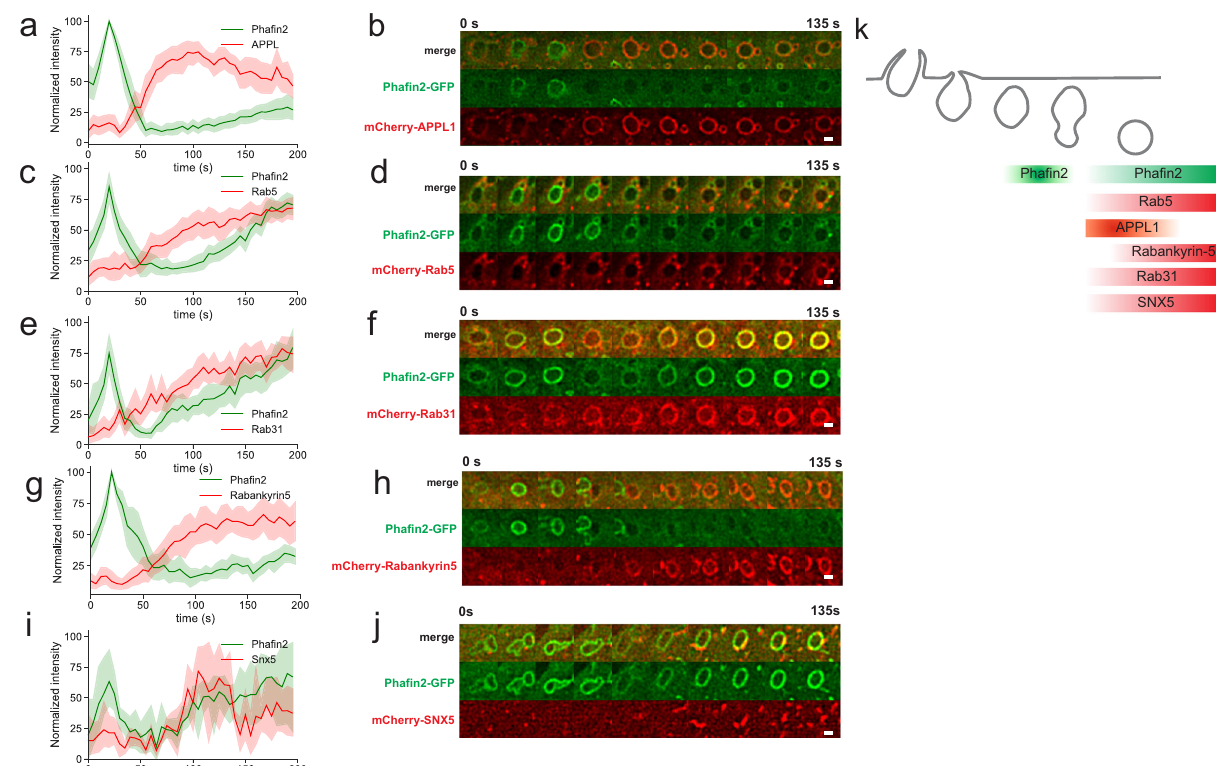
Fig. 2 Mapping Pha fi n2 dynamics in the endocytic pathway. a Pha fi n2 is recruited to forming macropinosomes prior to APPL1. Forming macropinosomes acquire a brief burst of Pha fi n2. Following this burst, Pha fi n2 is completely lost from these vesicles, and APPL1 is recruited. During further maturation, APPL1 is gradually replaced by a second, slower recruitment of Pha fi n2. n = 15 macropinosomes; mean + 95% CI. b Sequential images showing Pha fi n2 and APPL1 dynamics on a macropinosome. Representative image for n = 15 macropinosomes. Scale bar: 1 µ m. c Forming macropinosomes acquire a burst of Pha fi n2, followed by recruitment of RAB5. n = 14 macropinosomes, mean + 95% CI. Pha fi n2 shows a second gradual recruitment. d Sequential images showing Pha fi n2 and RAB5 dynamics on a macropinosome. Representative image for n = 14 macropinosomes. Scale bar: 1 µ m. e RAB31 is recruited after the initial Pha fi n2 recruitment. n = 10 macropinosomes, mean + 95% CI. f Sequential images showing Pha fi n2 and RAB31 dynamics on a macropinosome. Representative image for n = 10 macropinosomes. Scale bar: 1 µ m. g Forming macropinosomes acquire a burst of Pha fi n2, followed by recruitment of Rabankyrin-5. n = 12 macropinosomes, mean + 95% CI. Macropinosome maturation is accompanied by a second, gradual recruitment of Pha fi n2. h Sequential images showing Pha fi n2 and Rabankyrin-5 dynamics on a macropinosome. Representative image for n = 12 macropinosomes. Scale bar: 1 µ